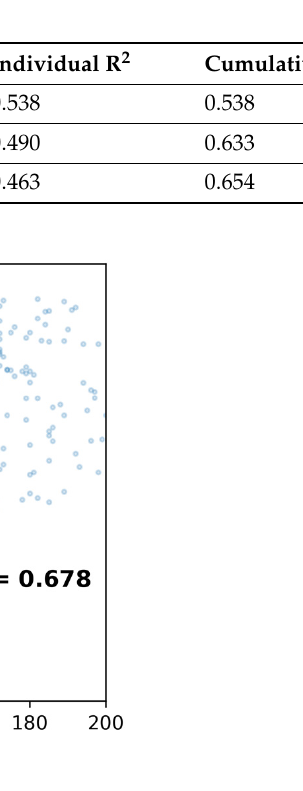
Figure 2. Predicted versus observed LFM of Adenostema fasciculatum (chamise) among all times and locations observed in this study.